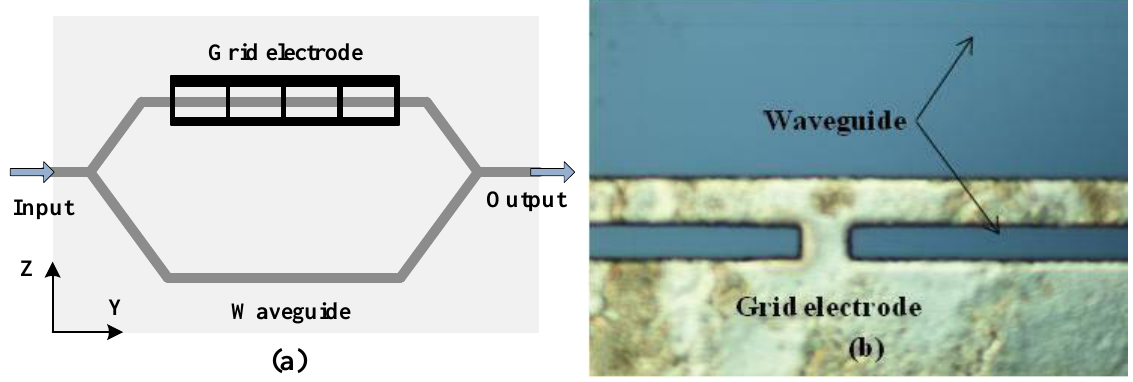
Figure 10. Mono-shielding electrode optimized as a grid type. ( a ) Schematic of the sensor; ( b ) Micrograph of the fabricated electrode.